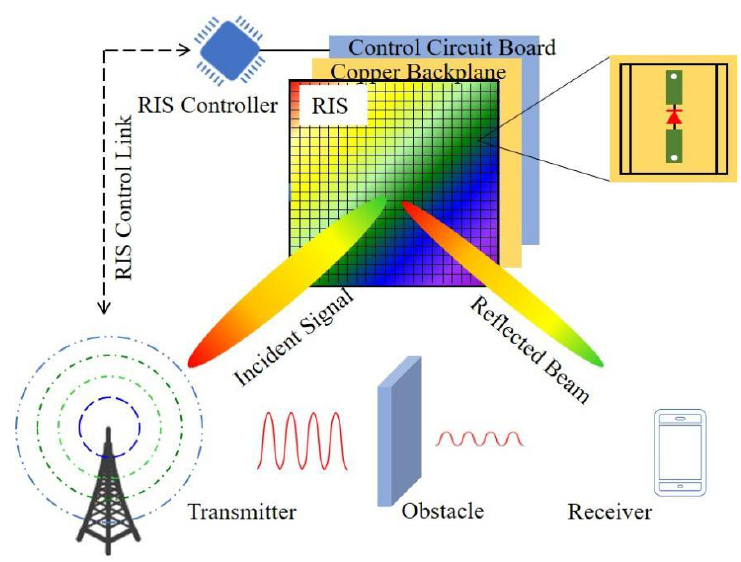
Figure 2. The structure of RIS.